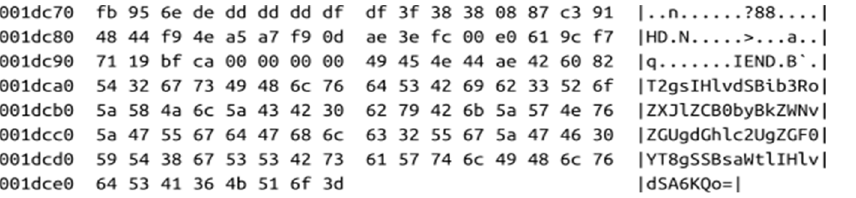
Figure 4. An example of data embedded in the PNG file after IEND marker (visible in hex dump).